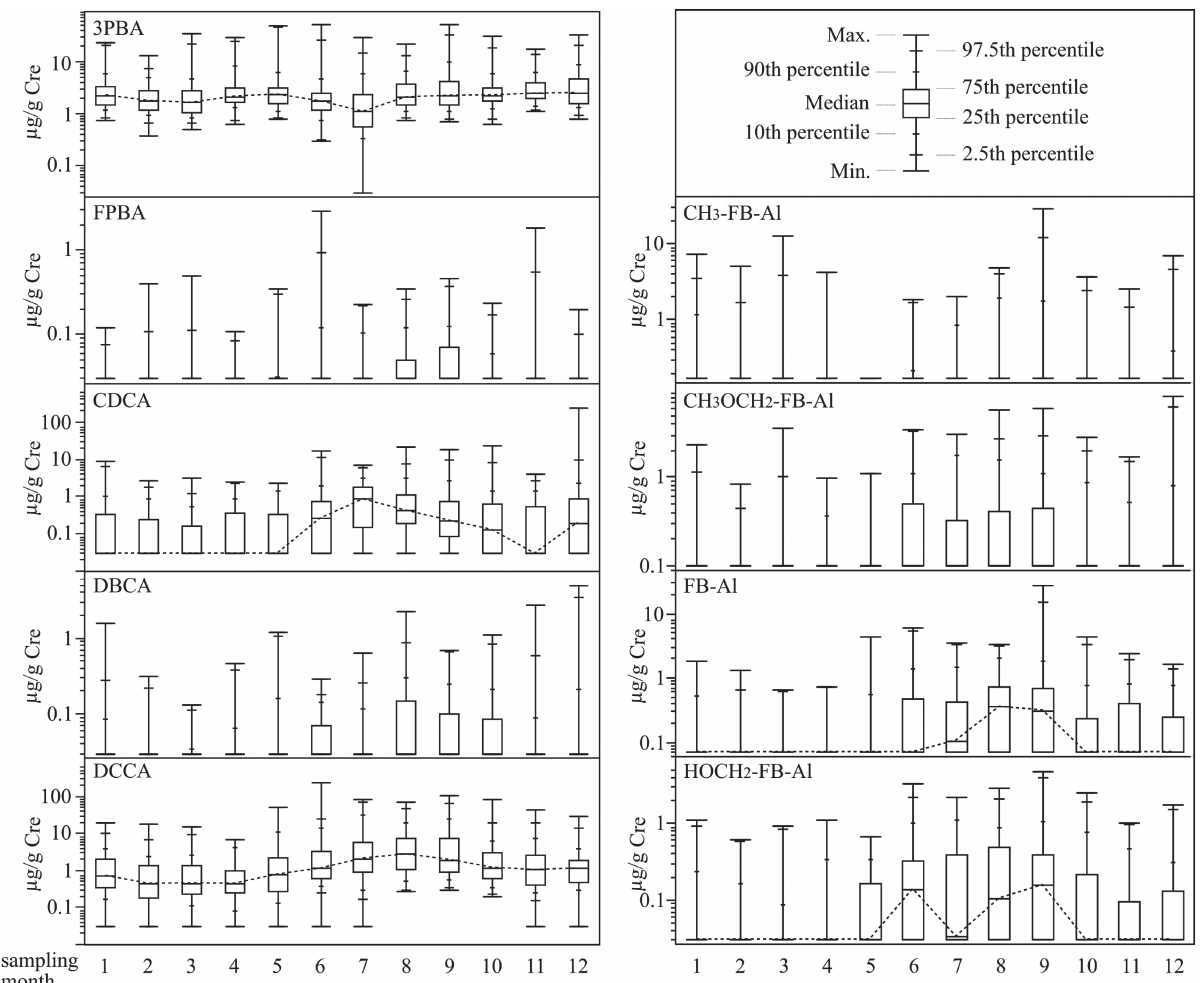
Fig. 1 Boxplot of urinary concentration of pyrethroid (PYR) metabolites (µg / g Cre) throughout a year. The dotted line connects the median values of each month. The limits of detection (LOD) values divided by the square root of 2 were assigned to urine samples with undetectable PYR metabolites. The value in parentheses below the x-axis indicates the number of subjects in each